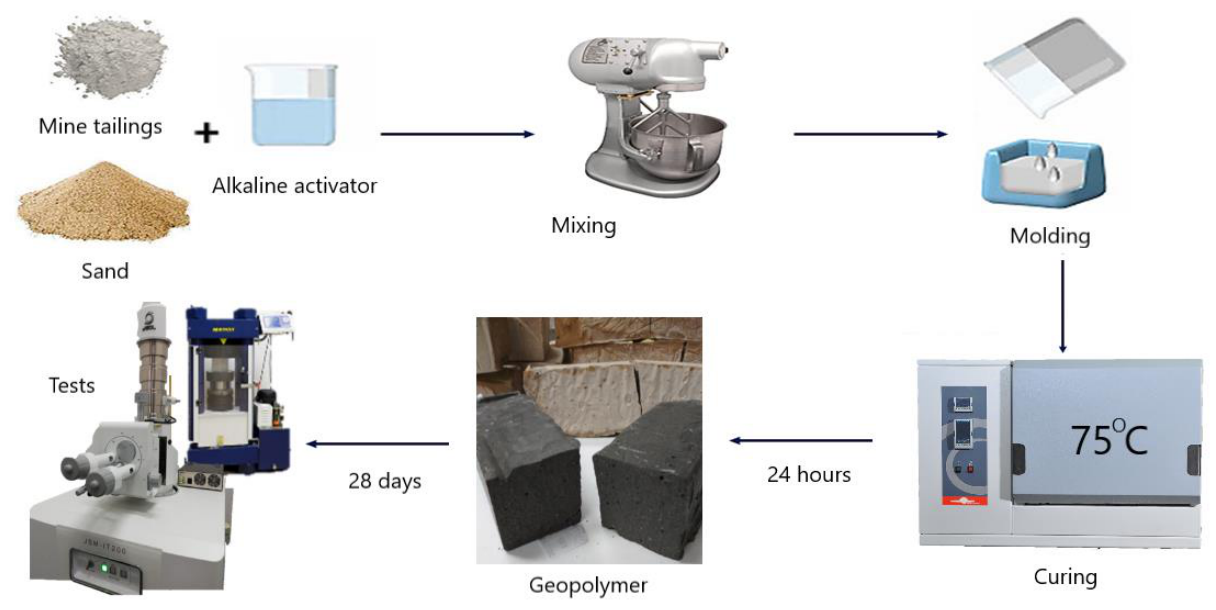
Figure 1. Scheme for sample preparation.